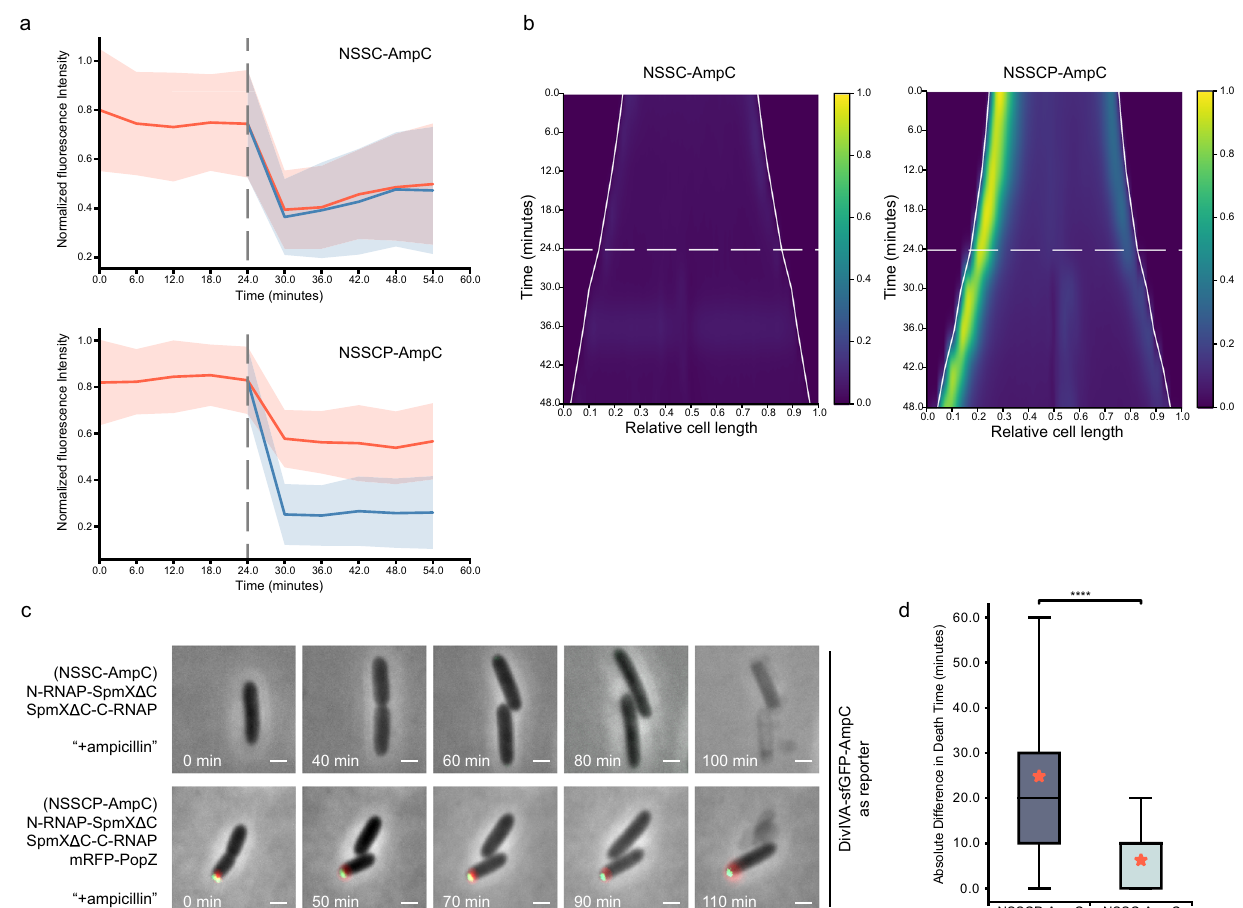
Fig. 7 Asymmetric division of cell fate determinant and differentiation in E. coli . a Quanti fi cation of total fl uorescence within mother (before cell division) and two daughter cells (after cell division) as shown in Fig. 6d. NSSCP-AmpC (bottom) and NSSC-AmpC (top) denote circuits with or without mRFP-PopZ, respectively. Fluorescence intensity was normalized by the maximal intensity in each cell. The gray dashed lines indicate the time of cell division. If mRFP- PopZ is present in the genetic circuit, red and blue denote daughter cells with or without the inheritance of mRFP-PopZ, respectively. If there is no PopZ in the circuit, the two daughters will be randomly assigned to red or blue groups. Solid lines indicate averages; colored belts indicate standard deviations; n = 60 and 61 cells for NSSC-AmpC and NSSCP-AmpC, respectively. b Kymographs of DivIVA-sfGFP-AmpC along the long axis of the cell over time. NSSCP- AmpC (right) and NSSC-AmpC (left) denote circuits with or without mRFP-PopZ, respectively. Fluorescence intensity of NSSC-AmpC was normalized to NSSCP-AmpC. PopZ is located at x = 0. White solid lines indicate cell boundaries; white dashed lines indicate the time points of cell division; n = 60 and 61 cells for NSSC-AmpC and NSSCP-AmpC, respectively. c Time-lapse imaging when NSSC-AmpC (top) and NSSCP-AmpC (bottom) were challenged with ampicillin; 100 mg mL − 1 ampicillin was added onto the agarose pad as the challenge after the mother cell fully divided into two daughter cells (at t = 60 min and 50 min for NSSC-AmpC and NSSCP-AmpC, respectively). Death was de fi ned at the time when a cell underwent membrane rupture/lysis 50 . Scale bars: 1 μ m. d Absolute difference in death time between sister cells upon ampicillin treatment for NSSC-AmpC and NSSCP-Amp. Center line, median; box limits, upper and lower quartiles; whiskers, 1.5× interquartile range. Red asterisks indicate averages (6.25 min and 24.83 min for NSSC-AmpC and NSSCP-AmpC, respectively); n = 64 and 61 cells for NSSC-AmpC and NSSCP-AmpC, respectively. Statistical difference was determined by two-tailed Student ’ s t -test; **** denotes P < 0.0001. Source data are provided as a Source Data fi